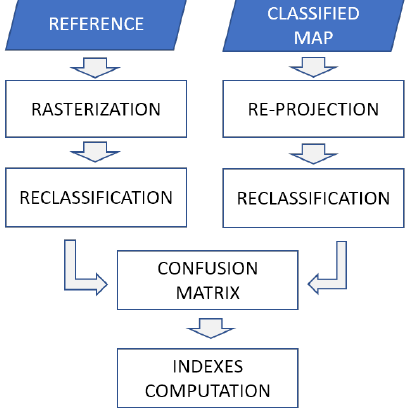
Figure 1. Data processing workflow